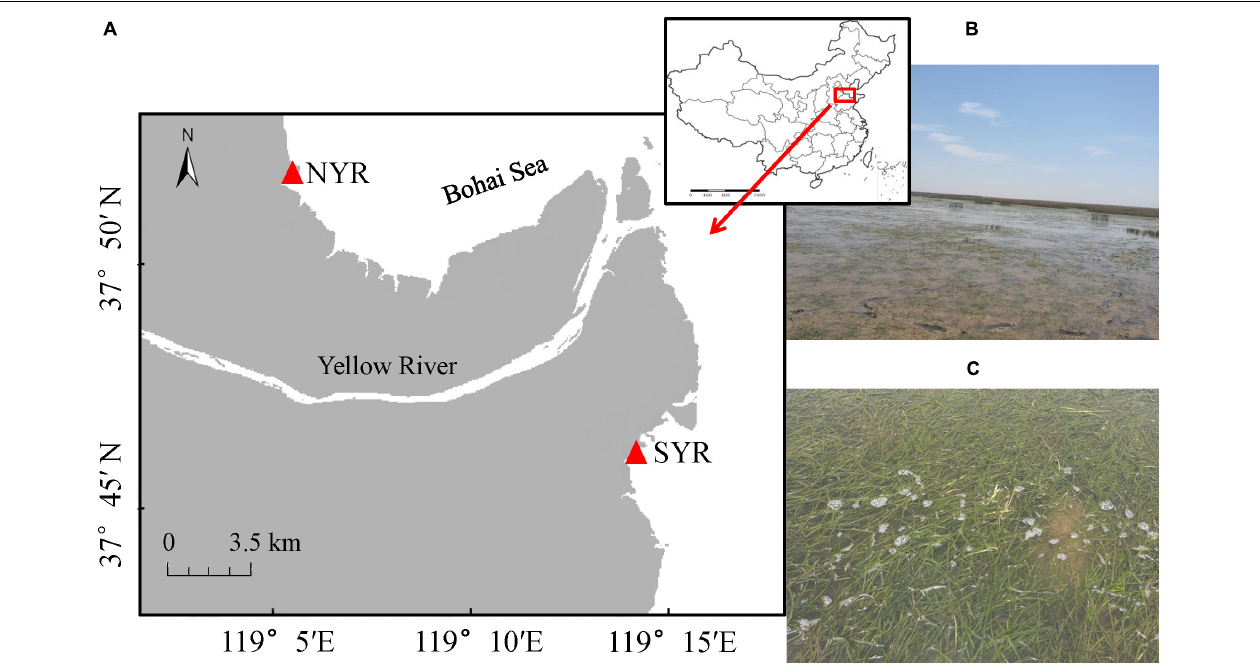
FIGURE 1 | Schematic diagram of the Zostera japonica meadows in the Yellow River Estuary: (A) location of the two study sites; (B) a illustrating photograph of the seagrass meadow in the north bank of the Yellow River Estuary (NYR); (C) a illustrating photograph of the seagrass meadow in the south bank of the Yellow River Estuary